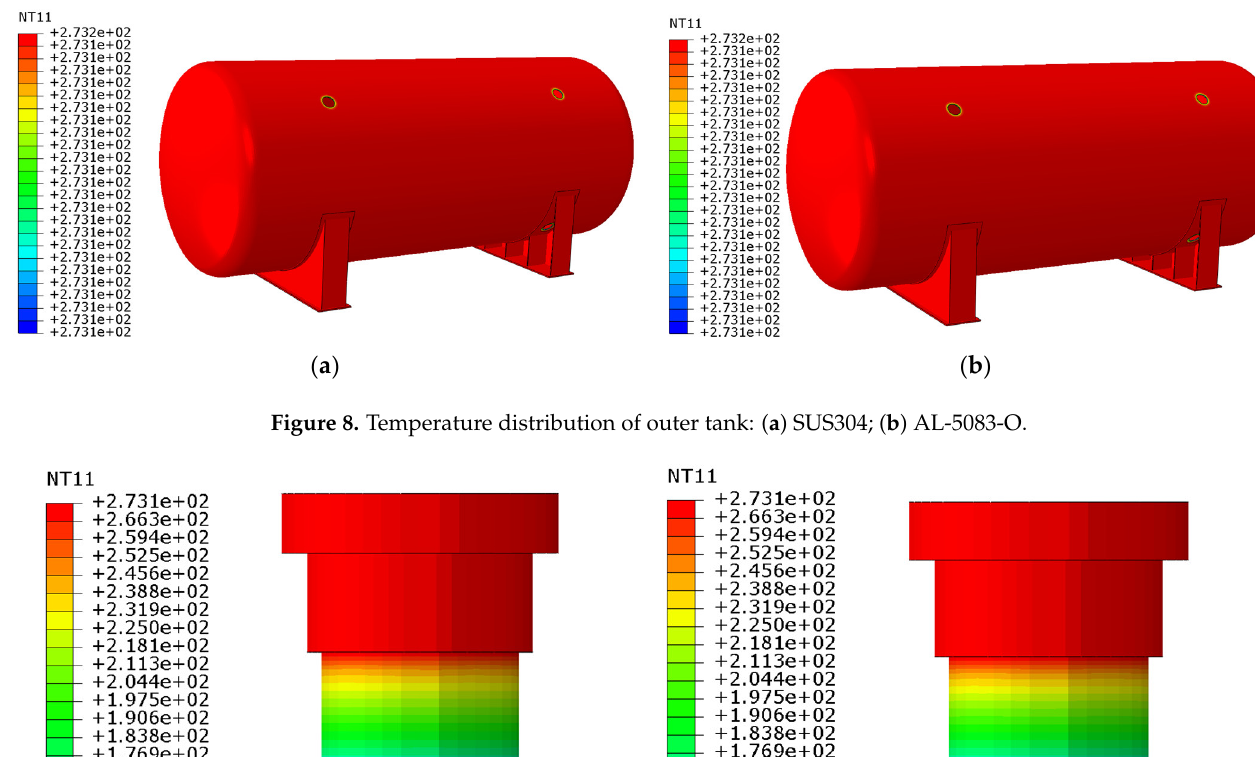
Figure 7. Temperature distribution of inner tank (AL-5083-O).